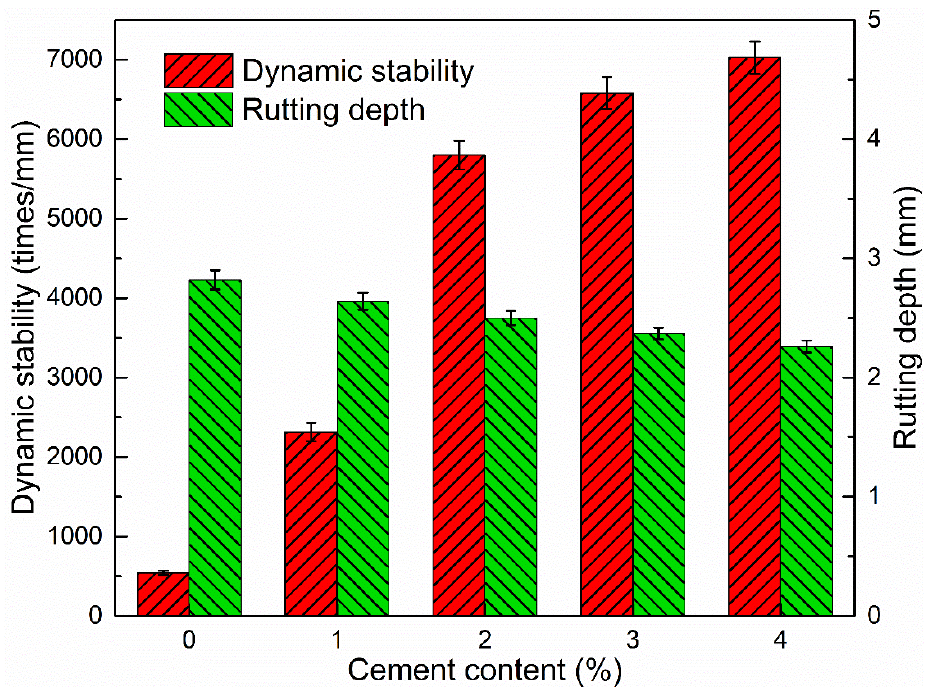
Figure 14. Influence of cement content on dynamic stability and rutting depth.